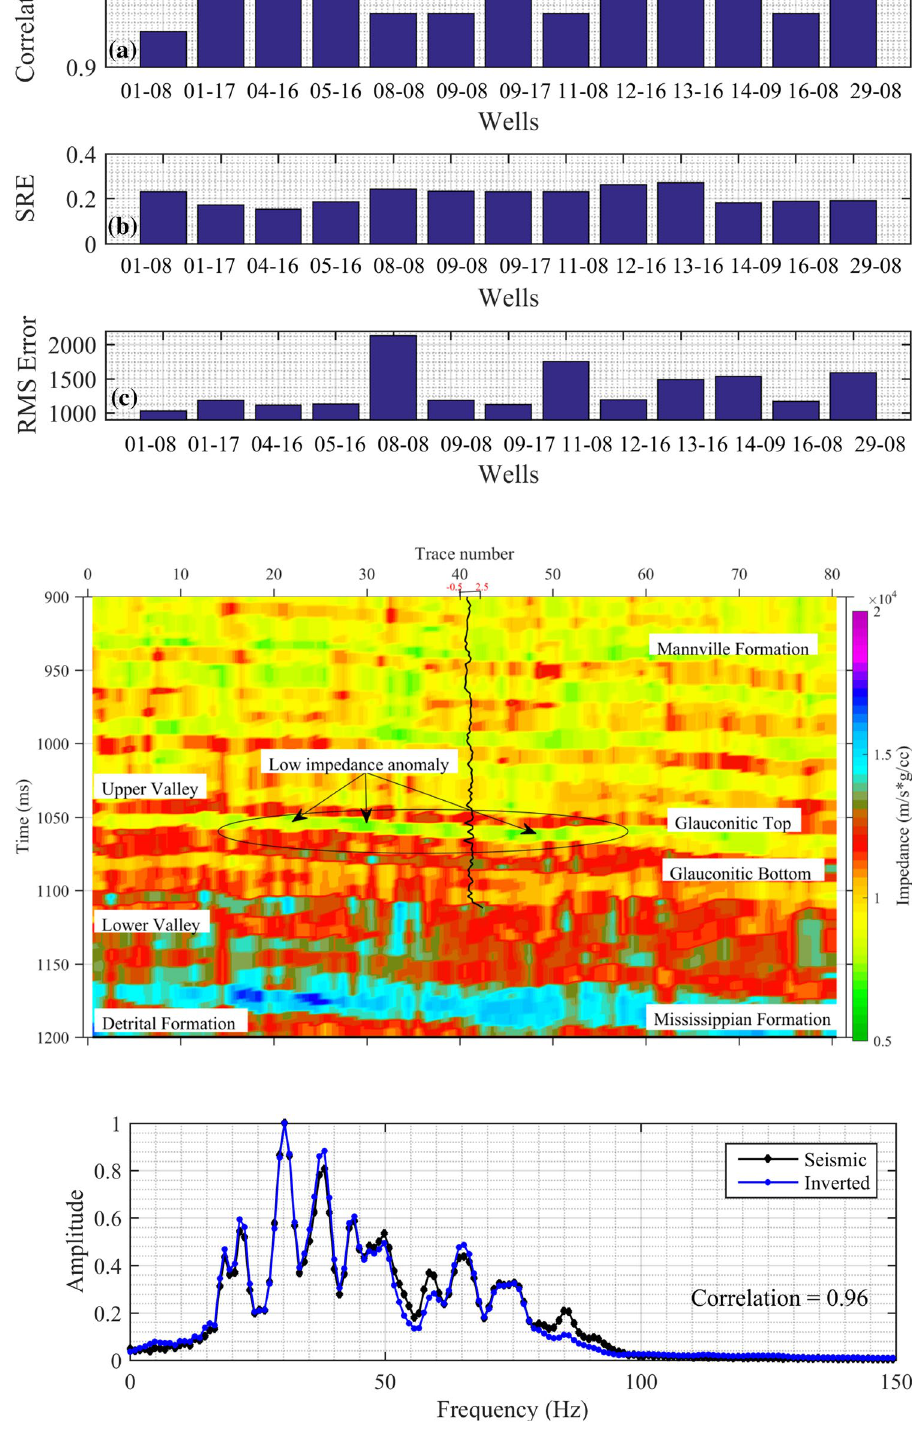
Fig. 6 Variation of a correlation coefficient, b synthetic relative error, and c root-mean-square error versus wells